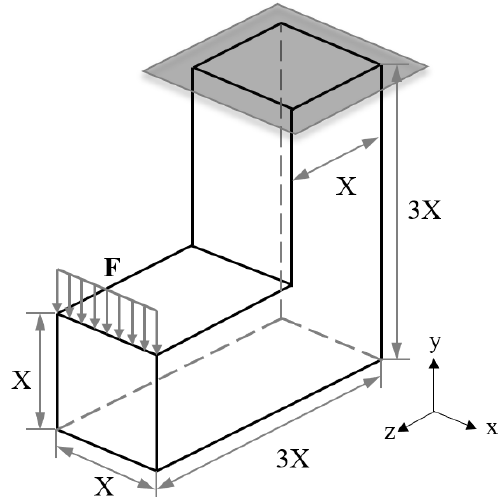
Figure 14. Dimensions and boundary conditions sketch of the L-shaped beam bending case study [49].